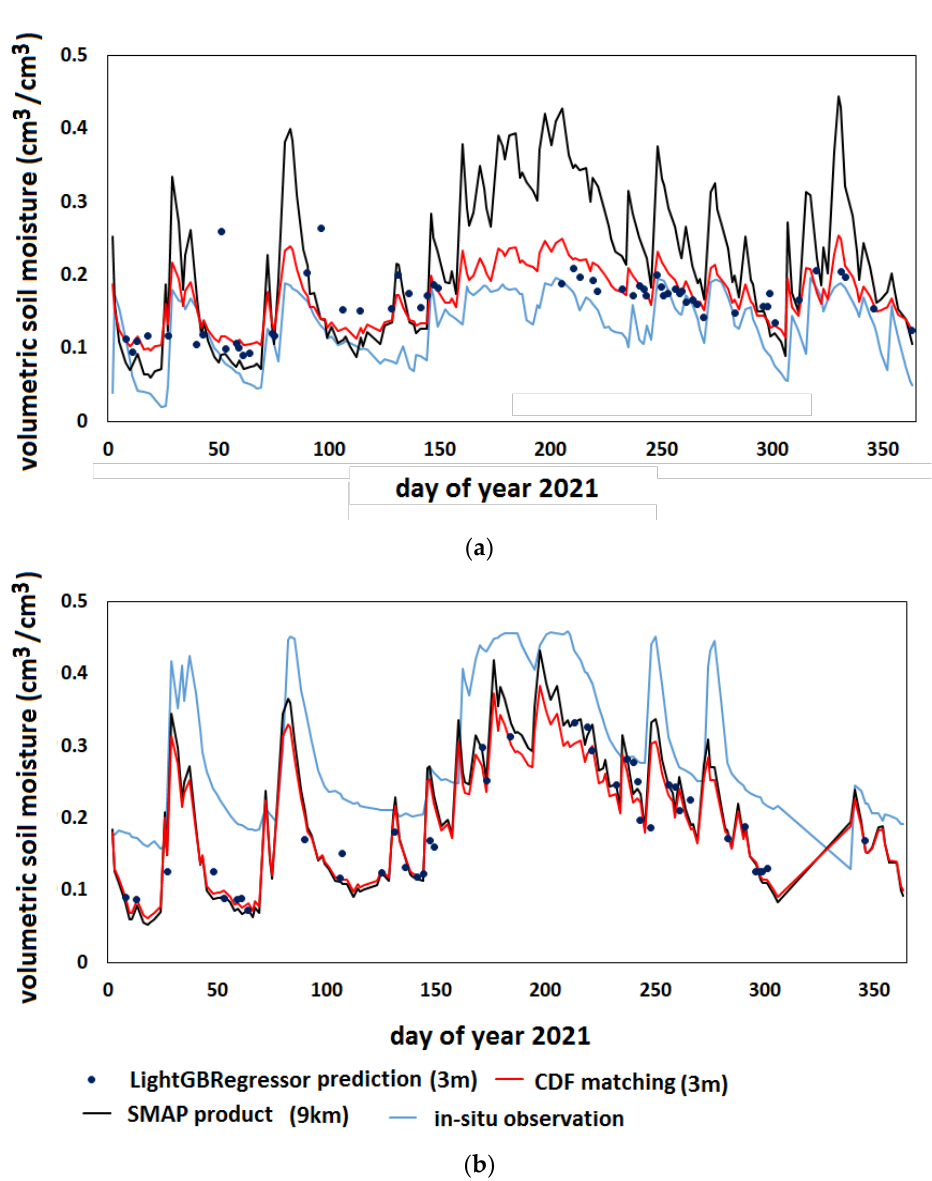
Figure 4. SSM comparisons among 9-km SMAP product, in situ measurements, and respective 3-m estimates derived using LightGBRegressor and CDF matching for sites Y12 ( a ) and Yb5e ( b ).